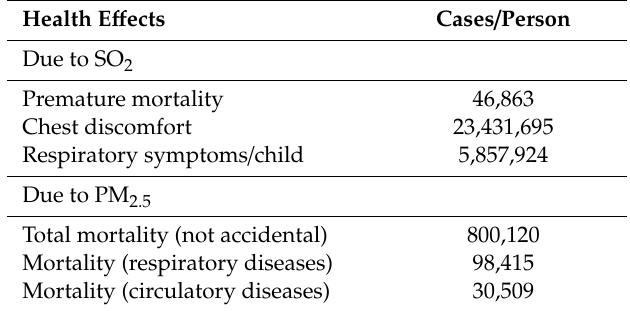
Table 5. Health e ff ects of SO 2 and PM 2.5 emissions in energy intensive sectors (2016).